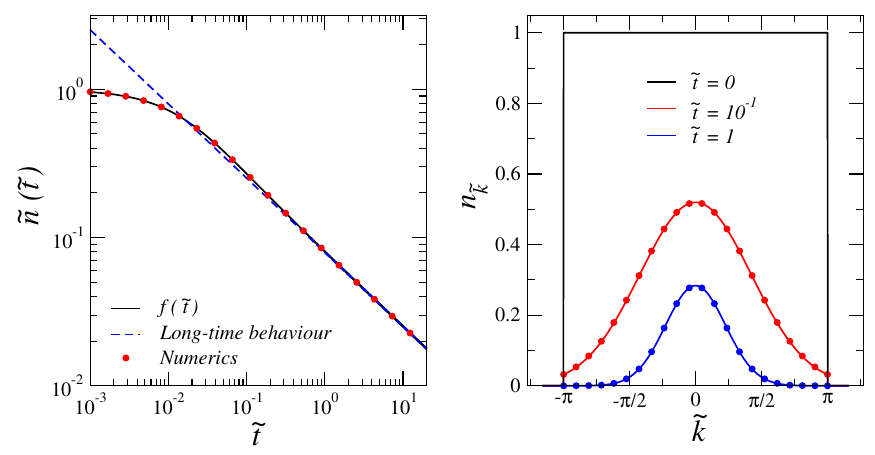
Figure 1: Left panel: Comparison of the numerically-computed normalised density ˜ n ( ˜ t ) (red dots) with the long-time behaviour given by Eq. (26) (blue dashed line). The black solid line represents Eq. (28), which faithfully reproduces the entire dy- namics of ˜ n ( ˜ t ) . Right panel: Density profile in ˜ k -space plotted for ˜ t = 0 (black), 0.1 (red), and 1 (blue). The circles represent the n ˜ for ˜ t = 0.1 and ˜ t = 1 computed with k the numerical integration of the Eqs. (18). The solid lines are obtained by taking ˜ n ( ˜ t ) from the numerical results and inserting it in Eq.